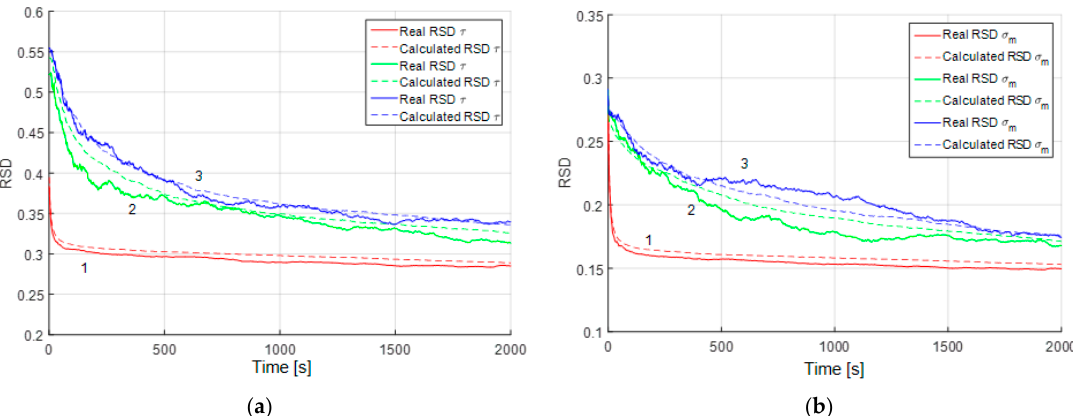
Figure 5. Real and calculated RSD for the parameters of the Markovian process: ( a ) Correlation interval; ( b ) RMS, 1 (red) – without white-noise component, 2 (green) – with white-noise component of known RMS, 3 (blue) – with white-noise component of unknown RMS (3).